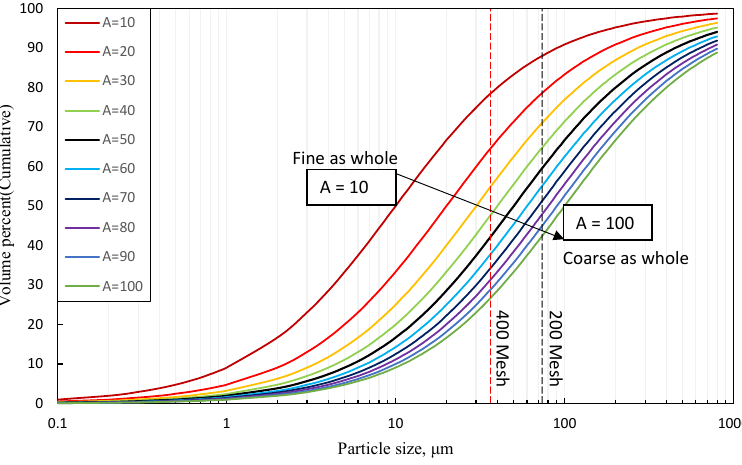
Figure 3. Model curve under different coefficient A. (b) Coefficient B represents the proportion of coarse and fine tailings